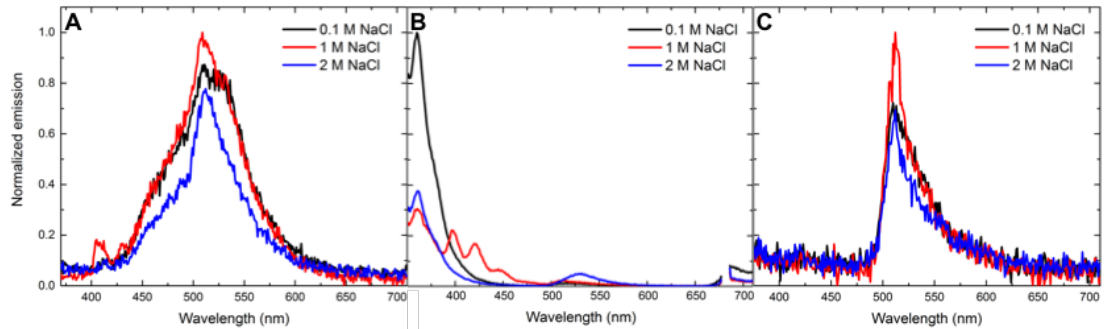
Figure 6. A comparison of the fluorescence emission in γ -cyclodextrin with 0.1 M NaCl (black line), 1 M NaCl (red line), and 2 M NaCl (blue line) with ( A ) analyte 2 ; ( B ) analyte 4 ; and ( C ) analyte 5 with compound 7 .